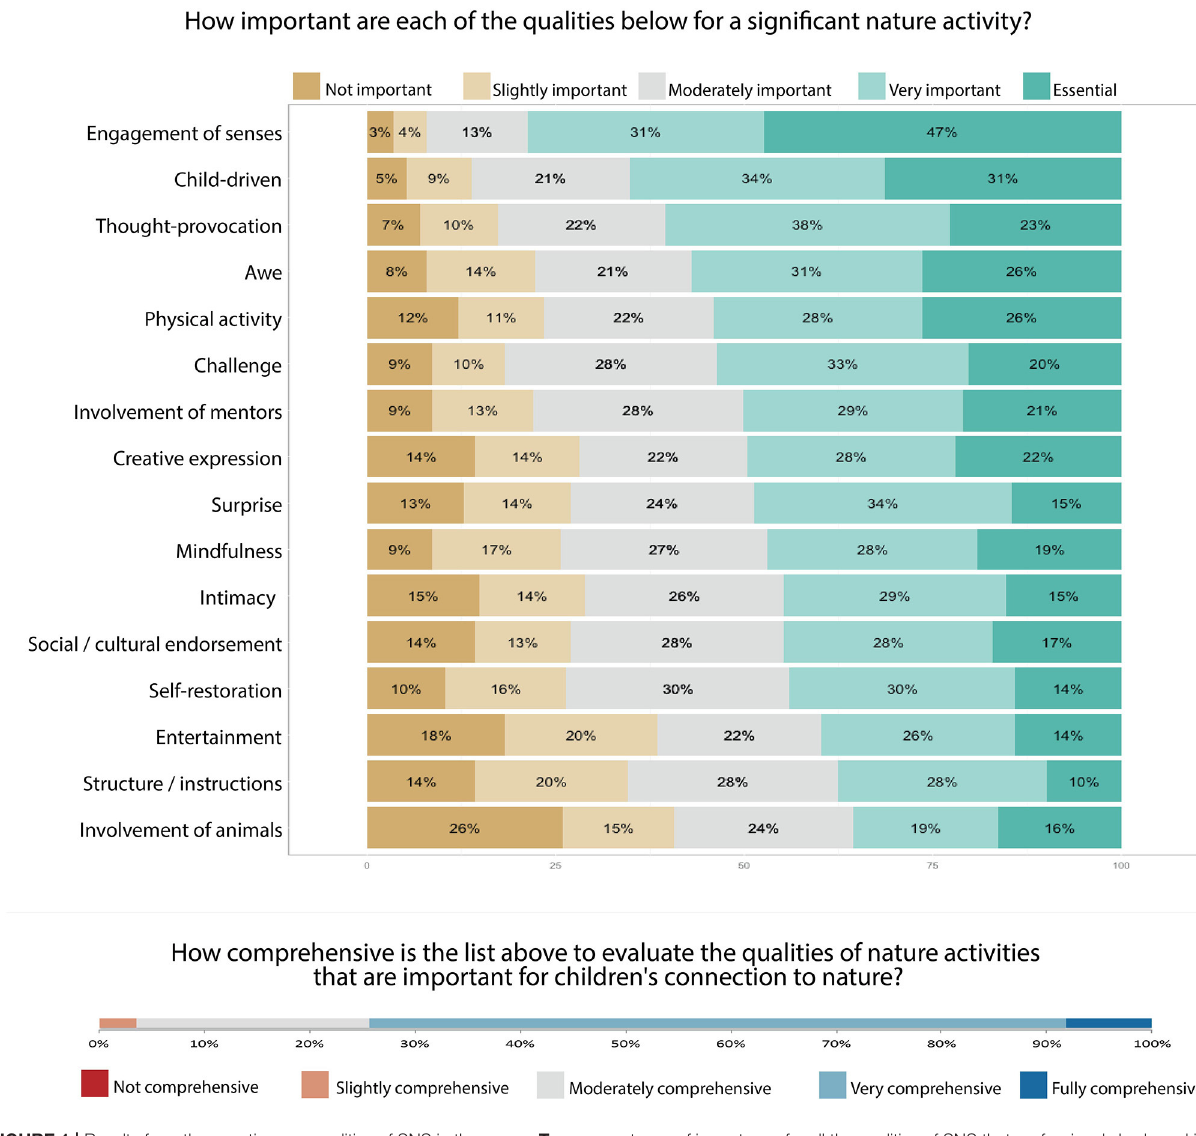
FIGURE 1 | Results from the questions on qualities of SNS in the survey. Top: percentages of importance for all the qualities of SNS that professionals had used in assessing the significant nature activities they reported to perform with children. Bottom: professionals’ responses on how comprehensive the list of qualities of SNS was for the assessment